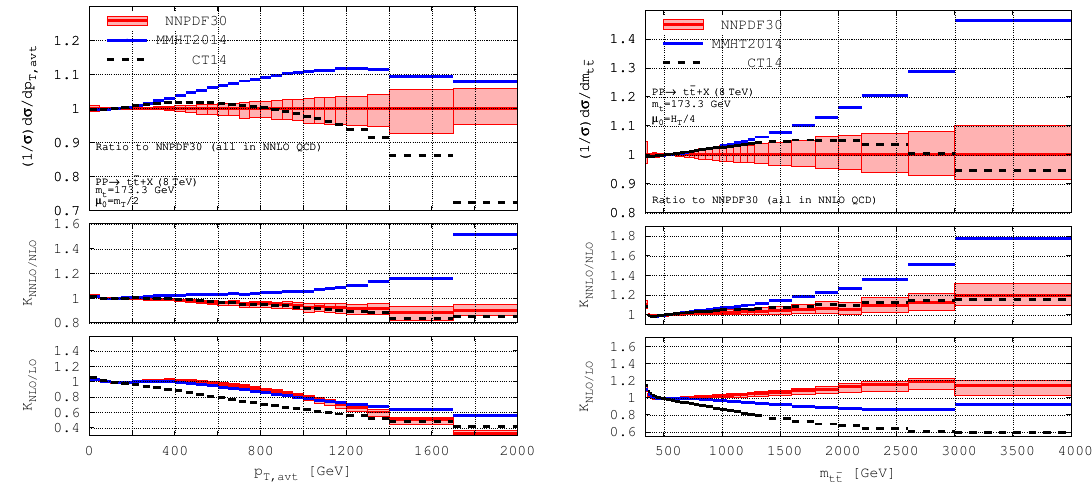
Figure 9 . As in (cid:12)gures 7, 8 but for the ratios of the normalised p